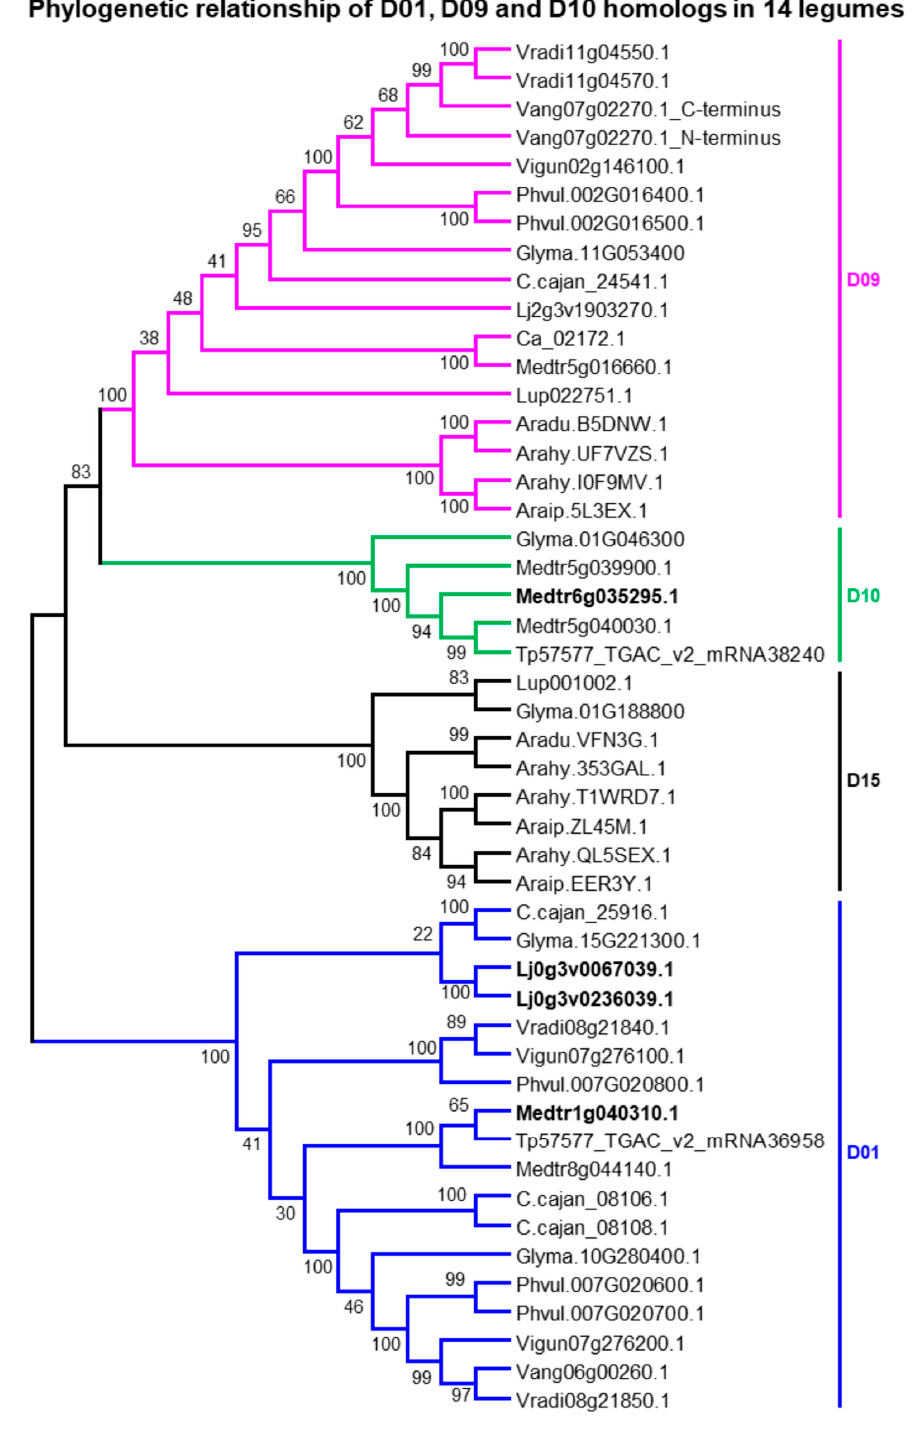
Figure 4. Phylogenetic relationship of putative ortholog loci (POL) D01, D09, and D10 homologs in 14 F4 legumes. The full-length sequence of Vang07g02270.1 (901 amino acids length) could be a sequencing error; its C-terminus (409 amino acids) and N-terminus (492 amino acids) both shared high amino acid percent identity with D09 members. Bolded genes are non-synteny homologs with any of the 14 legumes. See Table S9 for species and gene ID’s